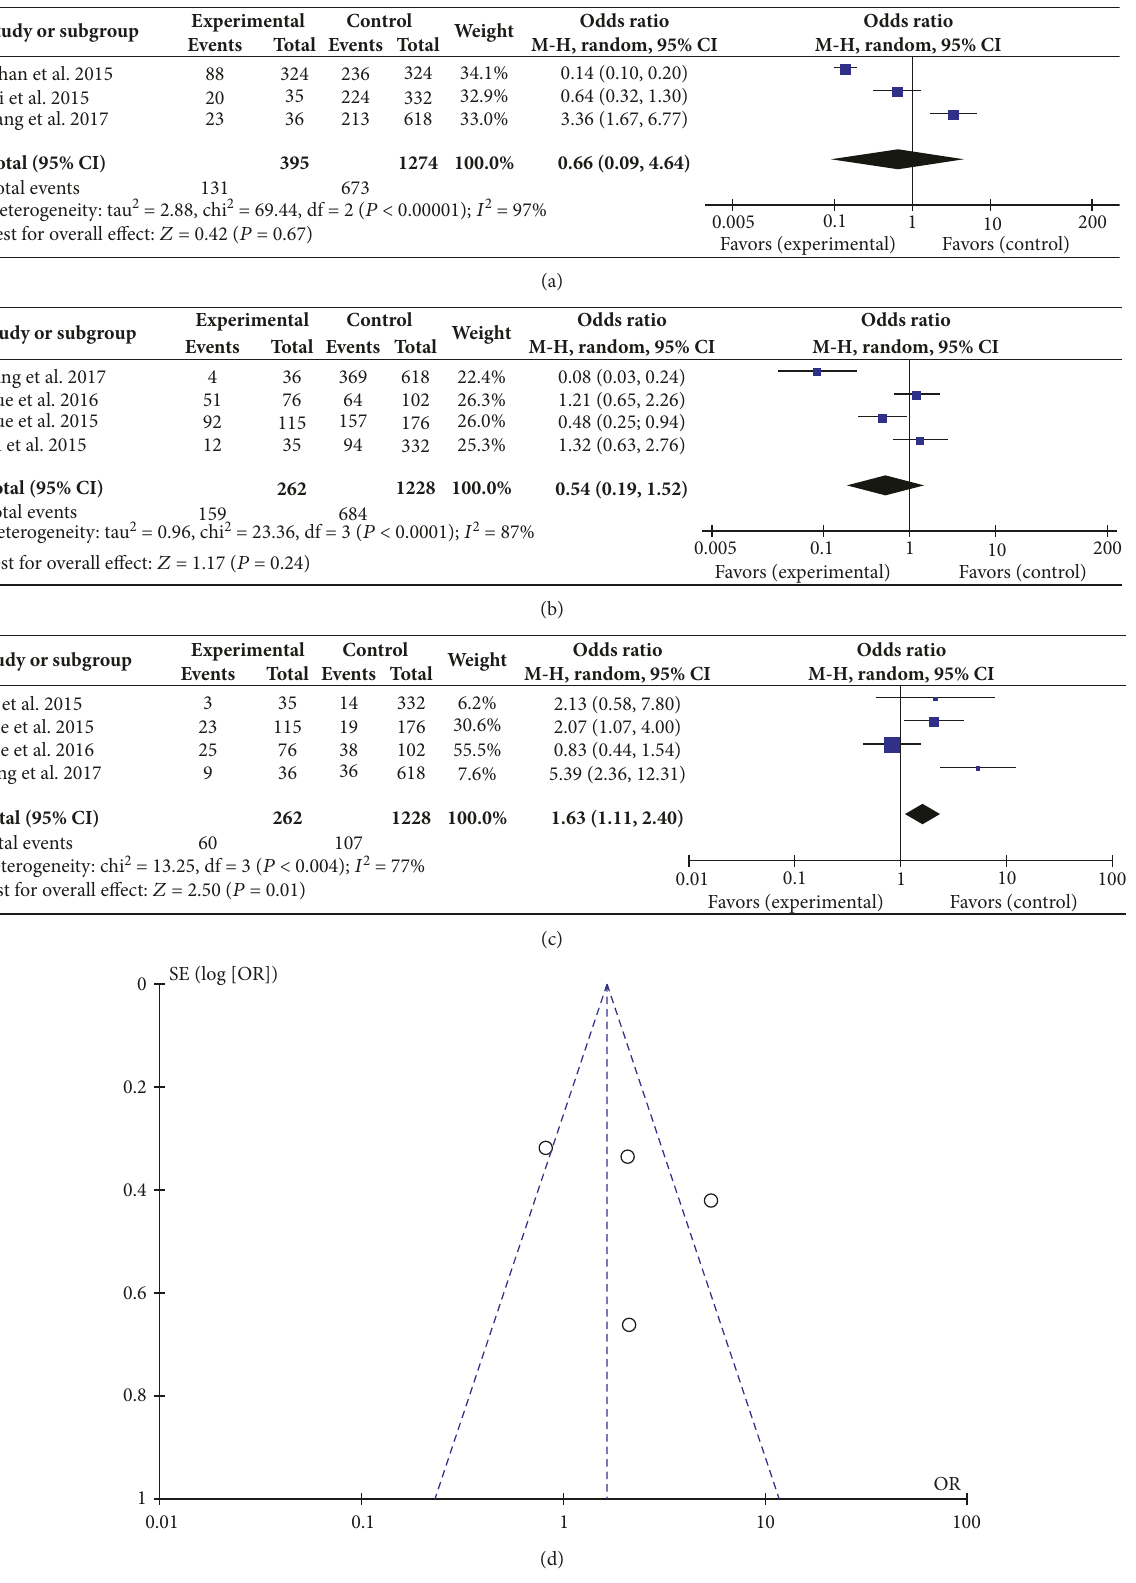
Figure 4: Correlation between platelet-to-lymphocyte ratio and event occurrence. (a) Forest plot of comparison of the included trials of BCLC-A; (b) forest plot of comparison of the included trials of BCLC-B; (c) forest plot of comparison of the included trials of BCLC-C; (d) funnel plot of comparison of the included trials of